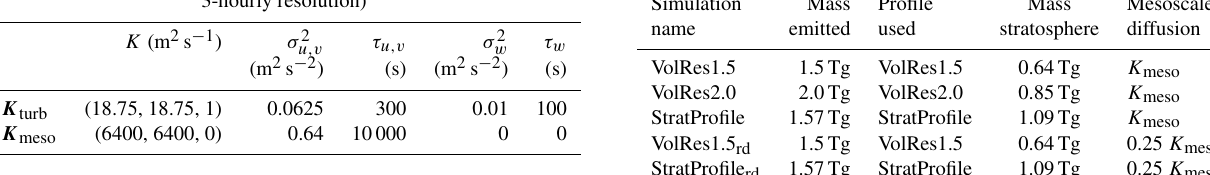
Table 1. The values for the diffusion parameter K used in NAME. Values are NWP dependent and are given here for the Met Office Unified Model global analysis (10km horizontal resolution, 59 lev- els) with a 3-hourly temporal resolution. Values for σ 2 are given instead of σ to be consistent with the values presented by Webster et al. (2018). Values are given for both the turbulence K turb and the mesoscale diffusion K meso that are used in NAME for the free atmosphere (i.e. excluding the boundary layer).